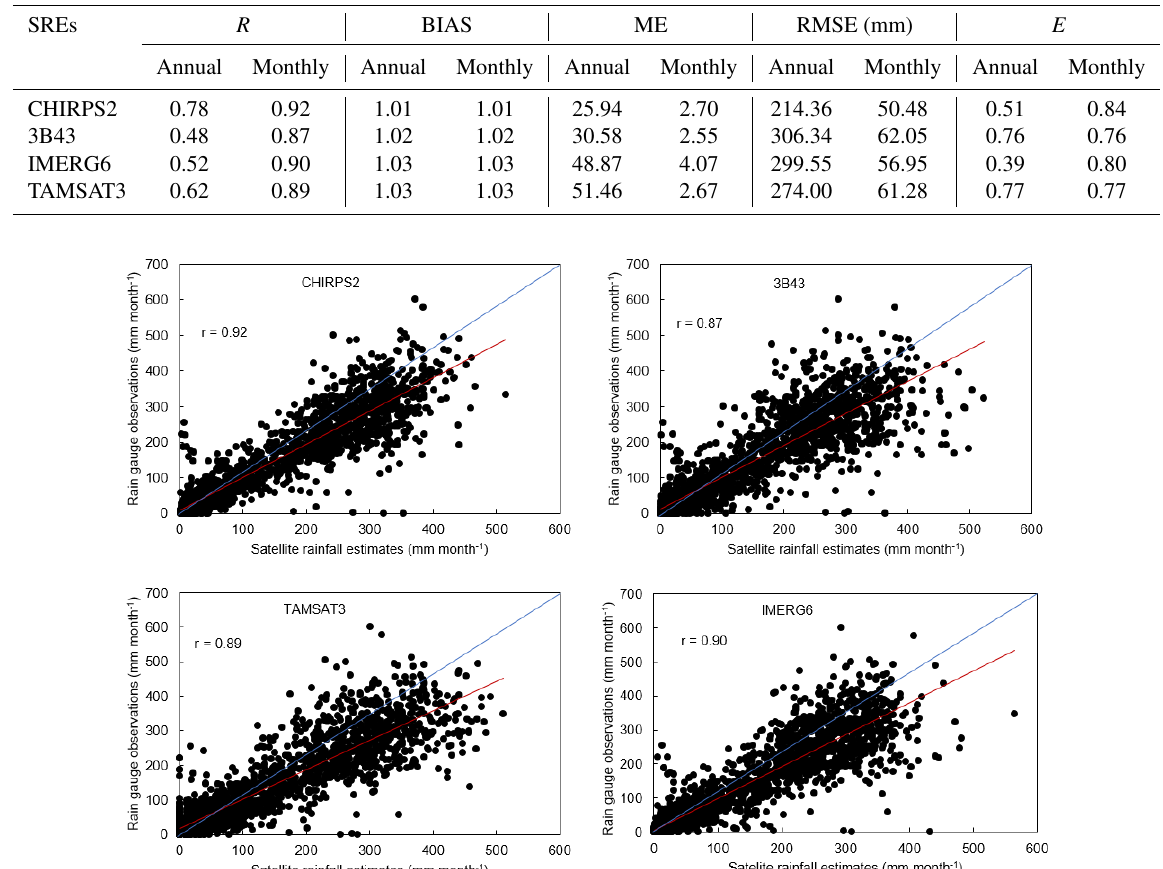
Figure 3. Correlation coefficient of the four SREs at monthly timescales over